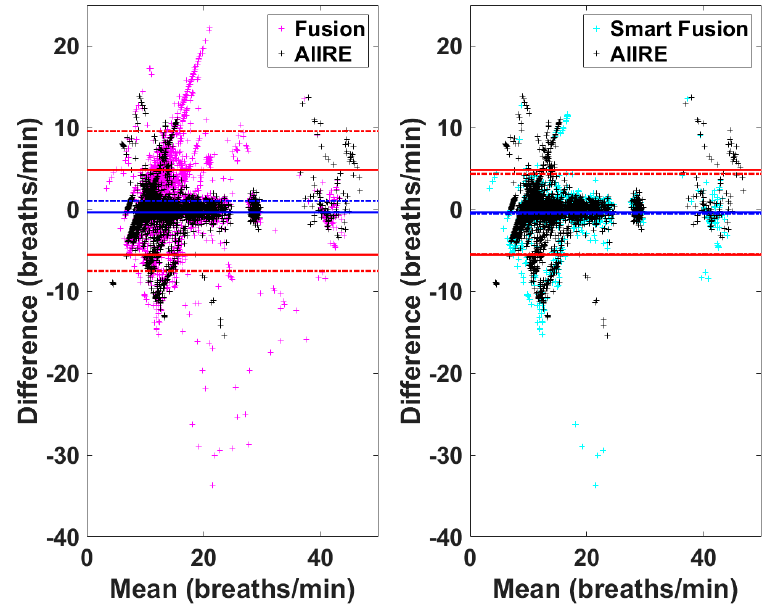
Figure 7. Bland–Altman plots comparing estimation errors of Adaptive Infinite Impulse response filter-based Respiratory rate Estimator (AIIRE) and two fusion algorithms (Fusion and Smart Fusion). The solid lines represent mean ±1.96 s.d. of the proposed method (AIIRE), and the dash–dot lines those of Fusion and Smart Fusion.